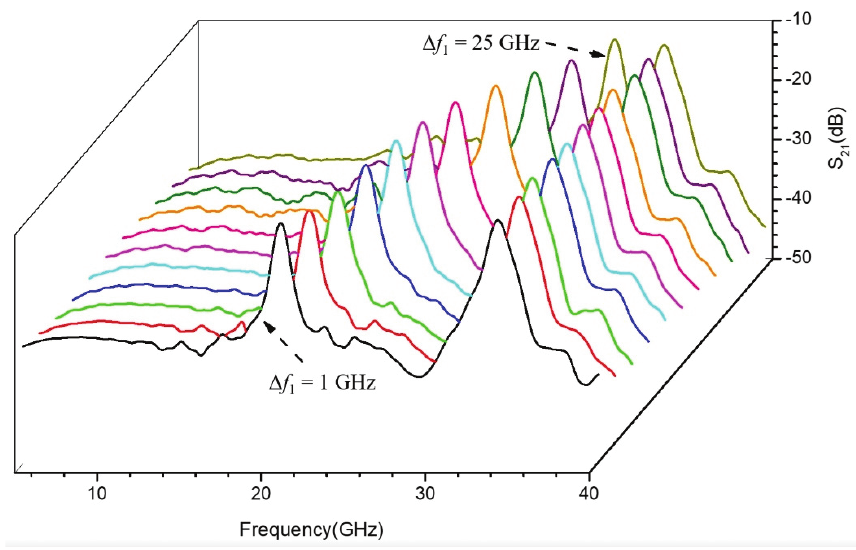
Figure 3. Results of the tunability of passband 1 by adjusting the detuning frequency (cid:775) f 1 from 1 to 25 GHz.